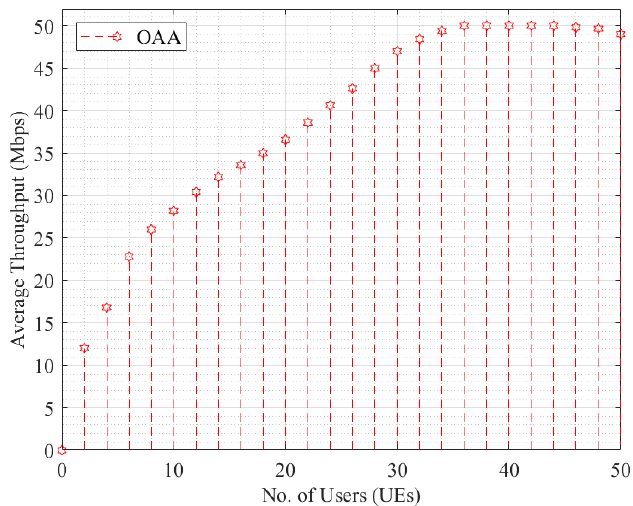
Figure 6. The number of users vs. corresponding average throughput.